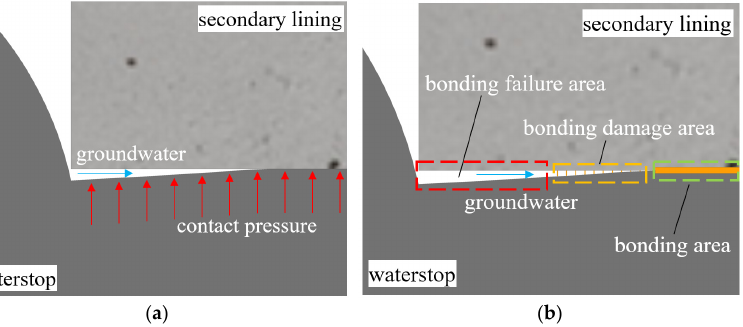
Figure 2. Waterproofing mechanism of a waterstop. ( a ) Extrusion sealing, ( b ) Bonding water plug-